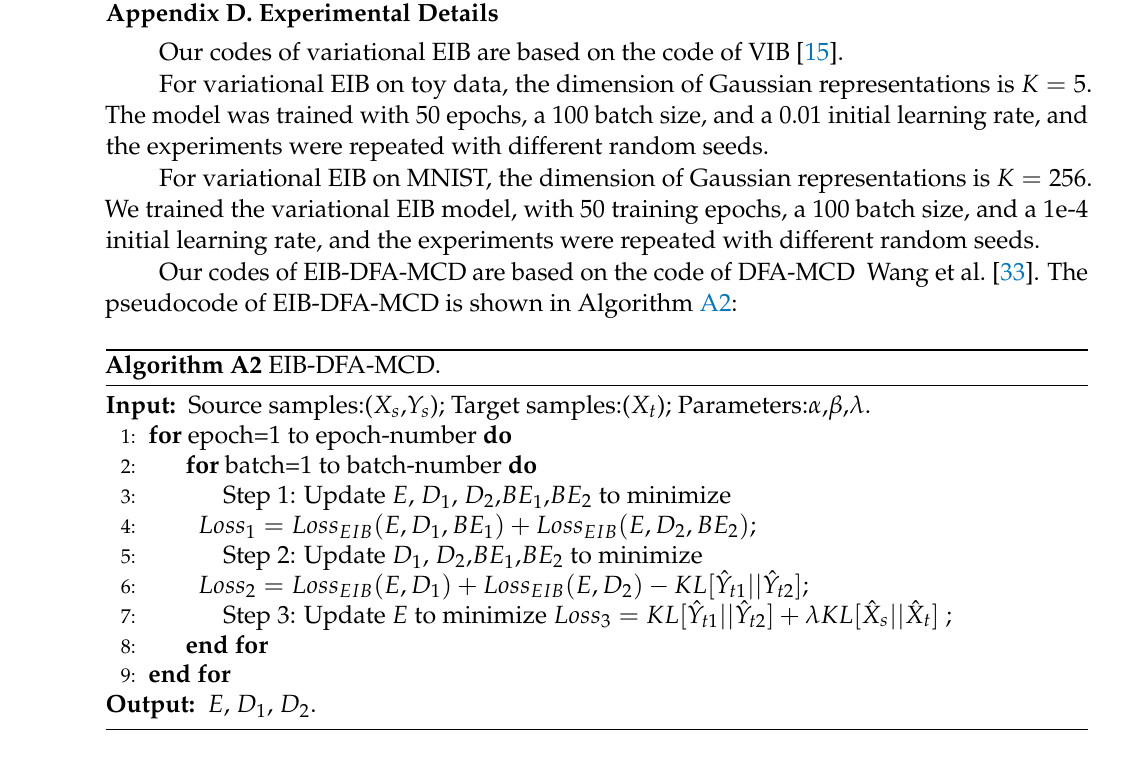
Figure A3. Left: Each curve is drawn by altering β . Right: Each curve is drawn by altering α .